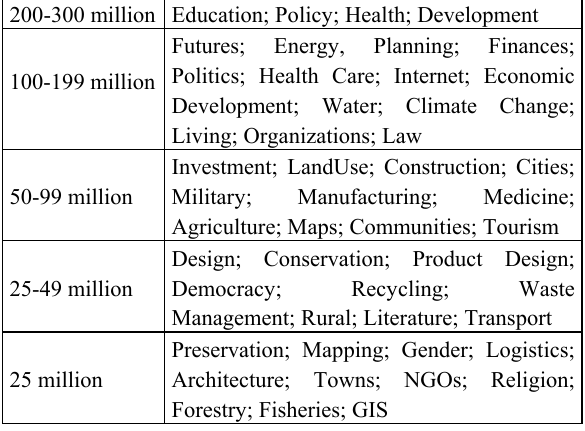
Table 1. Entries in Google Search Engine about Sustainability